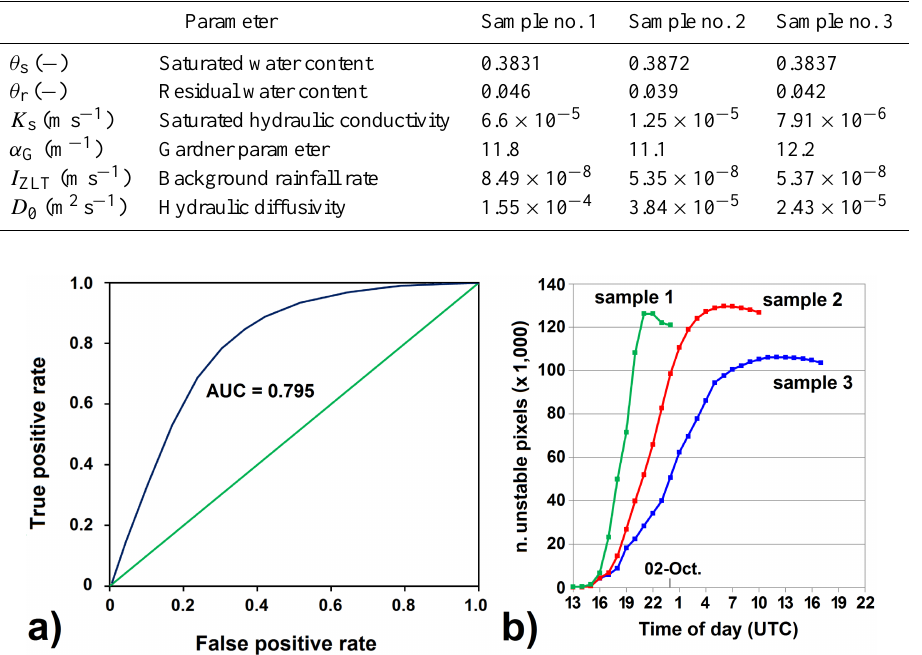
Figure 10. (a) ROC curve of the comparison between the TRIGRS final SF map and the 1 October 2009 landslide inventory map; (b) number of unstable pixels computed by TRIGRS during the event, considering three different grain size distributions of the investigated soil.